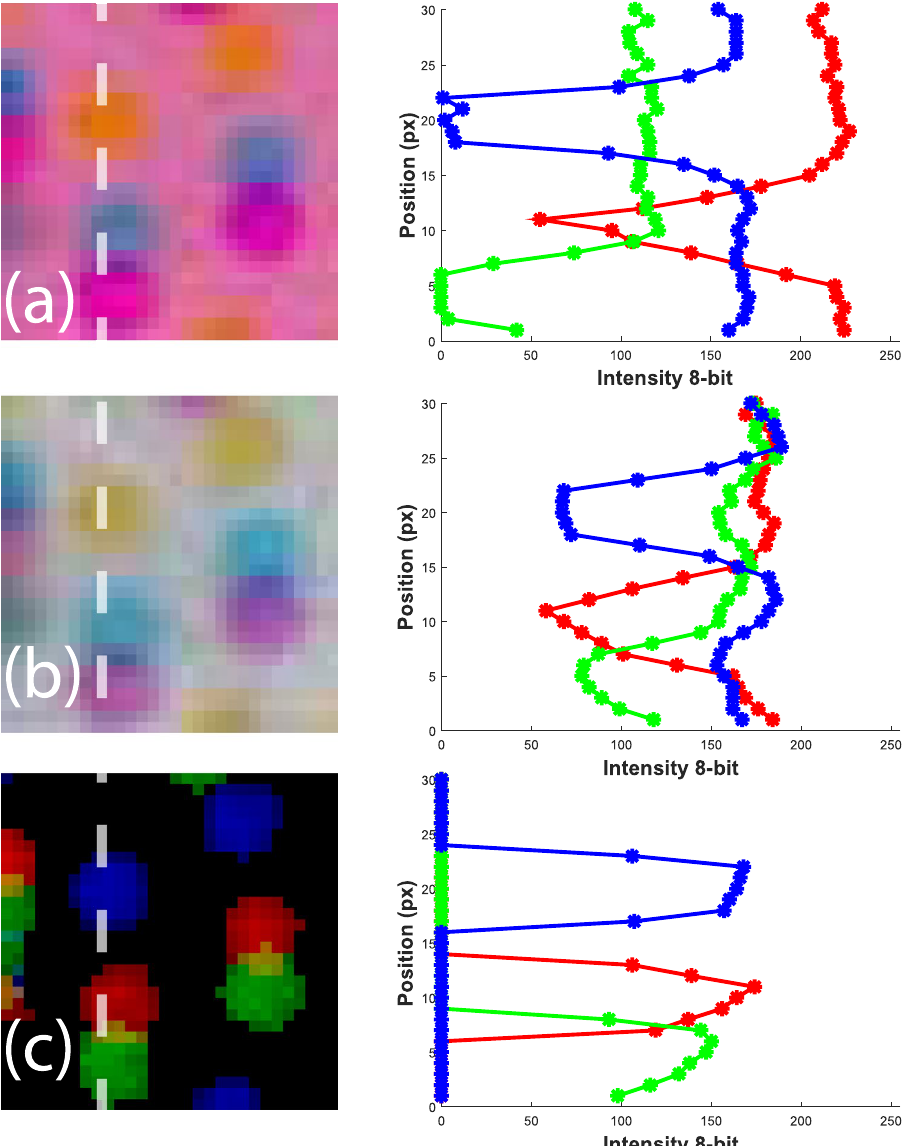
Figure 11. ( a ) Cropped portion of two particles from the raw captured image with the default color interpolation by the smartphone, ( b ) the interpolated raw image after separation of each channel array and combining them for clarity. ( c ) Inverted image after background subtraction and filtering by local standard deviation in each subregion, combining the color channels for clarity. For comparison, the color intensities are plotted on the right side, along cuts through the image, marked by the dashed